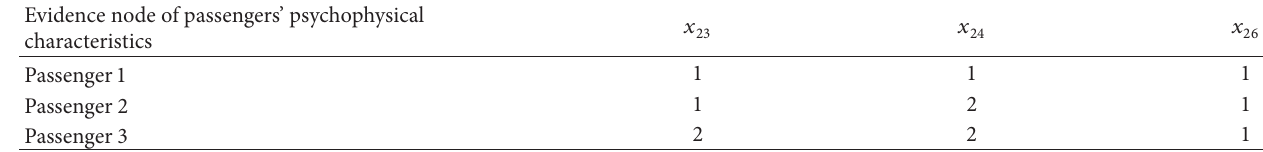
Table 9: Node states of psychophysical characteristics of selected respondents.